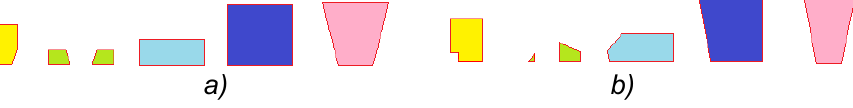
Figure 2 – Geometric primitives as constituent elements of PSTs a) FRATs; b)